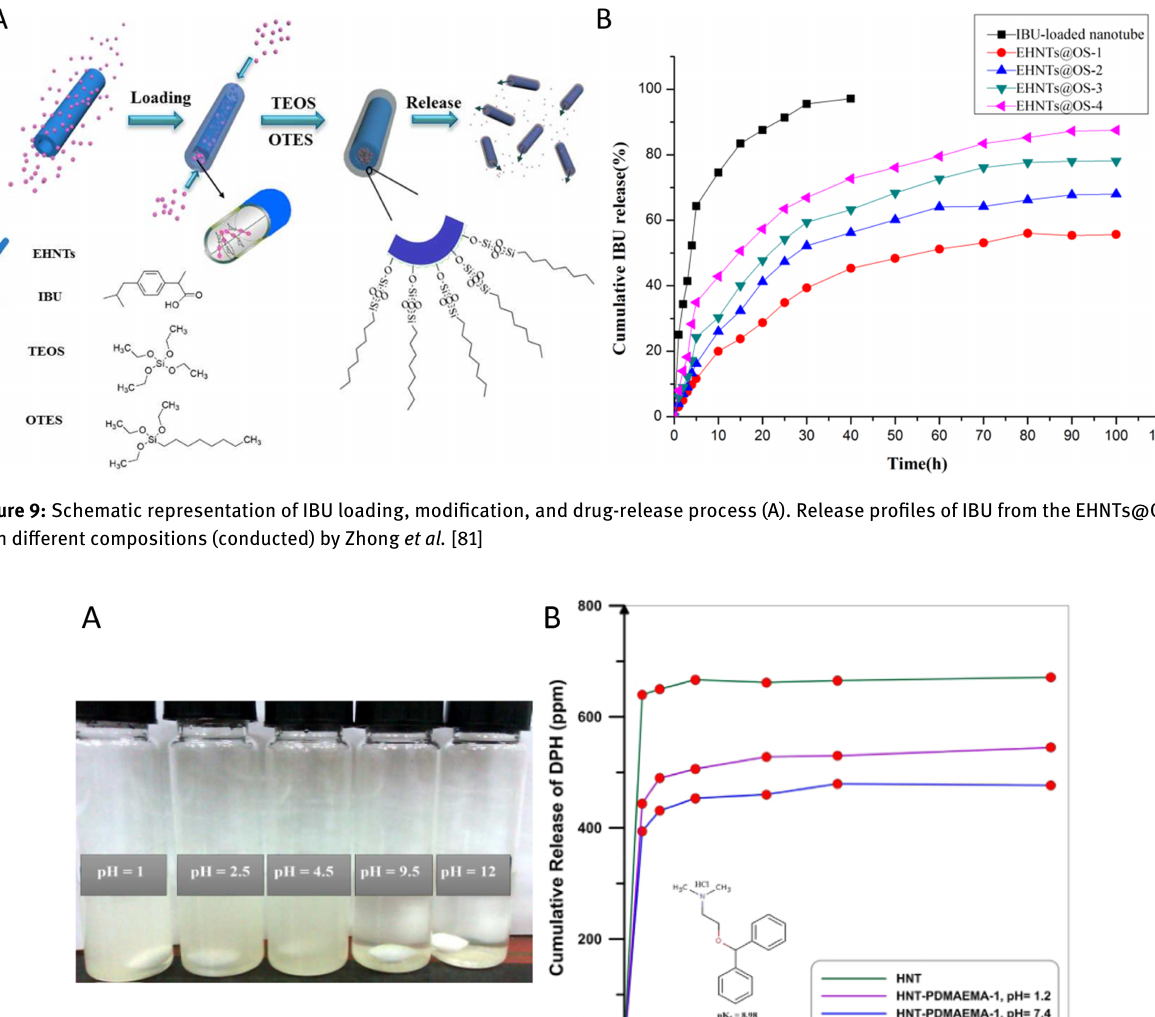
achieved under overexpressed H